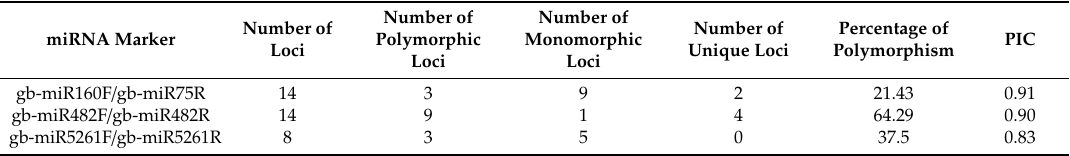
Table 7. Details of miRNA marker assay with various parameters revealing the discriminatory power of each marker.